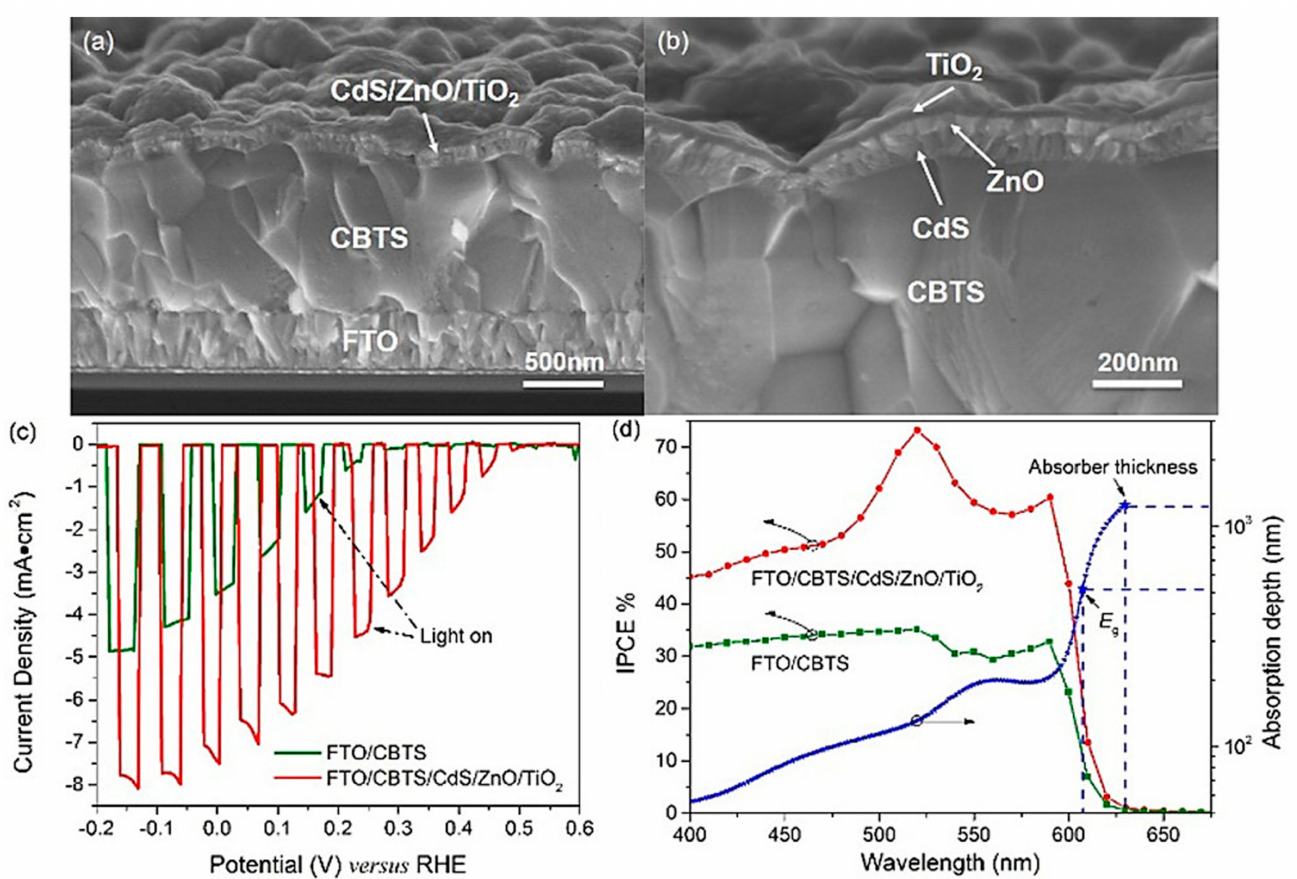
Figure 8. ( a ) Cross-sectional SEM image of the FTO/CBTS/CdS/ZnO/TiO 2 photocathode; ( b ) magni- fied cross-sectional SEM image showing the structural detail at the interface of CBTS/CdS/ZnO/TiO 2 ; ( c ) J–V curves of FTO/CBTS and FTO/CBTS/CdS/ZnO/TiO 2 ; ( d ) IPCE spectra measured at the potential of 0 V versus RHE and the absorption depth (1/ α ) of CBTS. Produced with the permission of ref. [118]. Copyright 2016, American Chemical